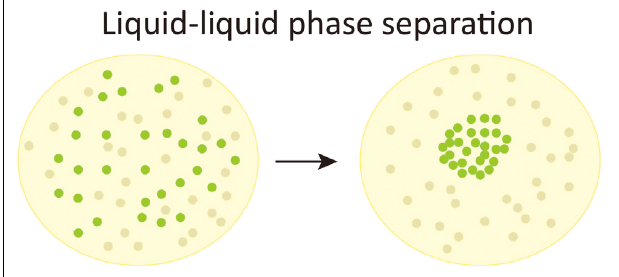
FIGURE 1 | Liquid-liquid phase separation. A schematic chart of liquid-liquid phase separation (LLPS). In a solution composed of evenly distributed solute molecules (the green bubbles) and solvent molecules (gray bubbles), when LLPS occurs, the solute molecules condense to form a membraneless liquid-like phase and leaves a surrounding region absent of the solute